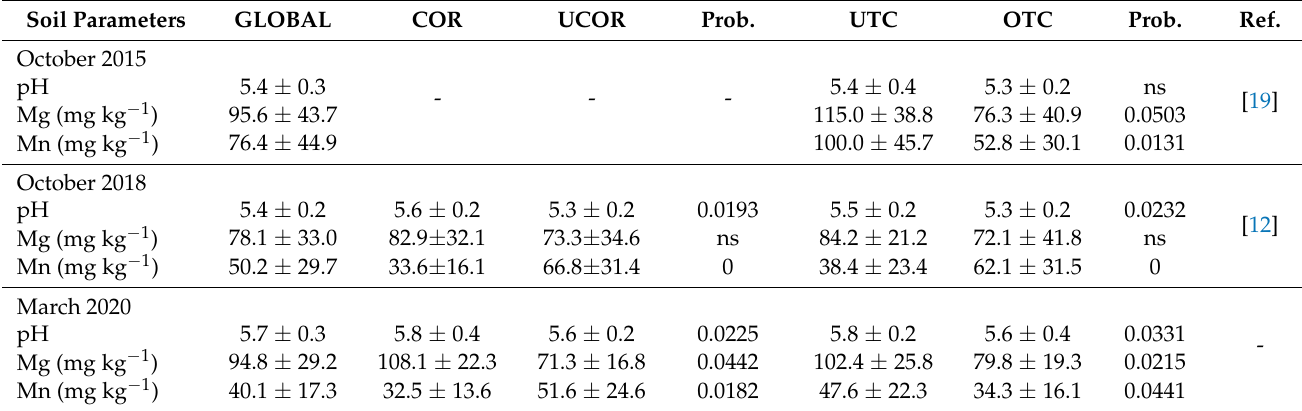
Table 1. Descriptive (mean ± standard deviation) and inferential statistics of soil parameters in experimental field (0–0.30 m depth). Soil Parameters GLOBAL COR UCOR Prob. UTC OTC Prob. Ref. [19]pH 5.4 ± - -